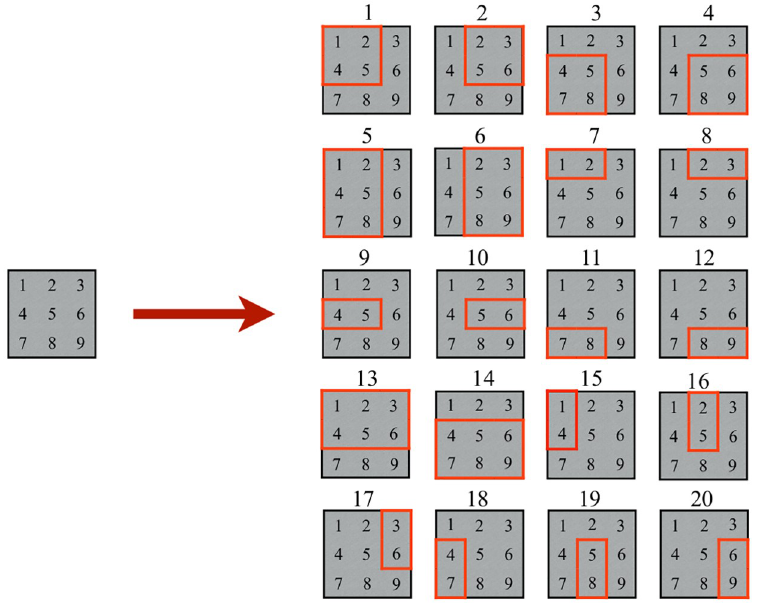
Fig 6. P&C with rotations. The new set of valid positions when rotations by 90˚ are allowed.